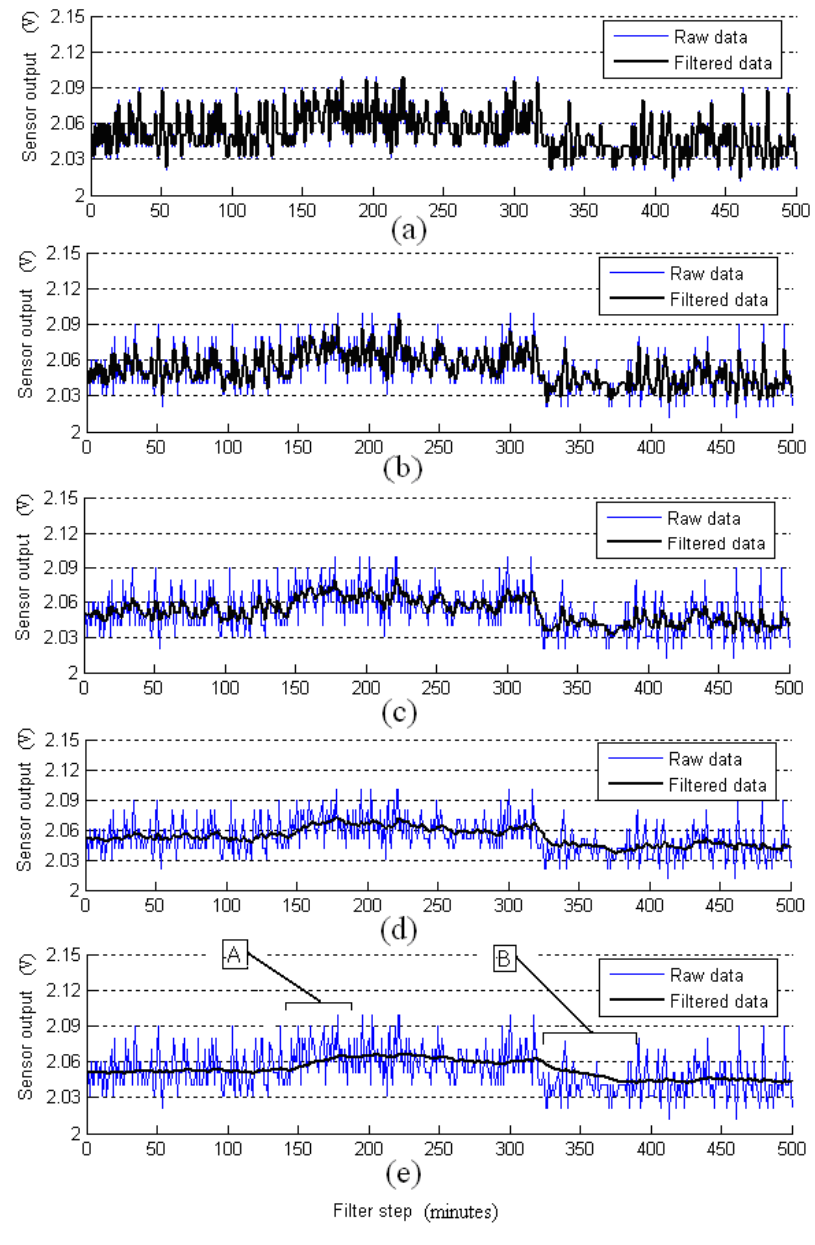
Figure 6. Filter results at different variance ratio factors  .